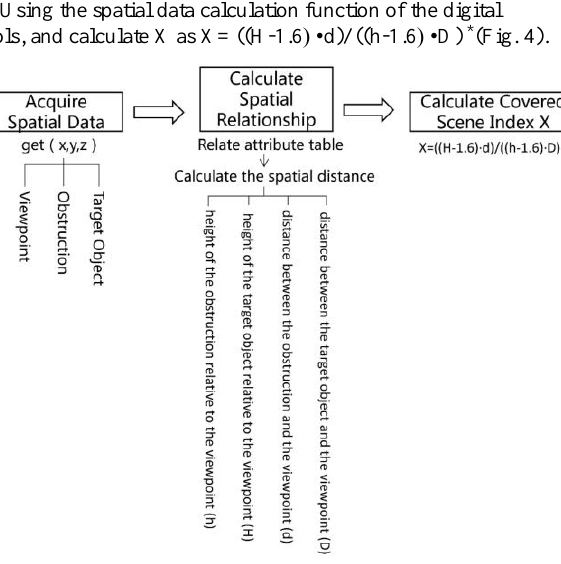
Fig.4 The process of covered scene index analysis